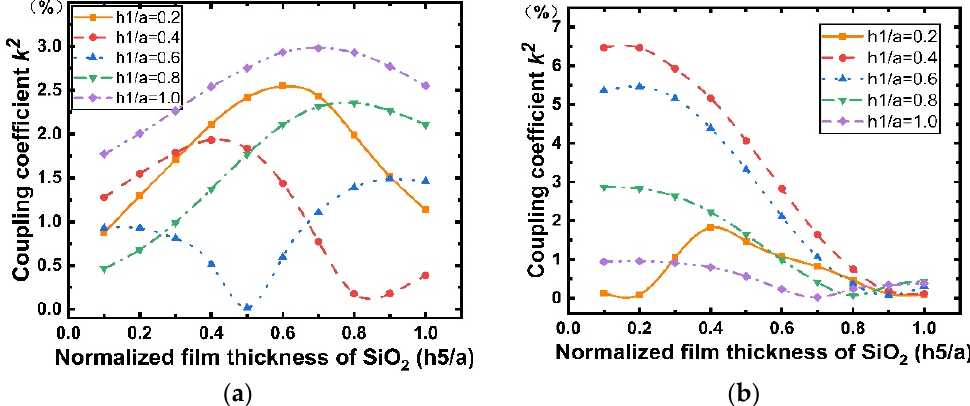
Figure 14. Dispersion curves of the Rayleigh and Sezawa waves electromechanical coupling coef- ficient ( k 2 ) calculated for various values of h 5 / a for the structure SiO 2 /IDT/LiNbO 3 /diamond/Si. ( a ) Rayleigh mode; ( b ) Sezawa mode.